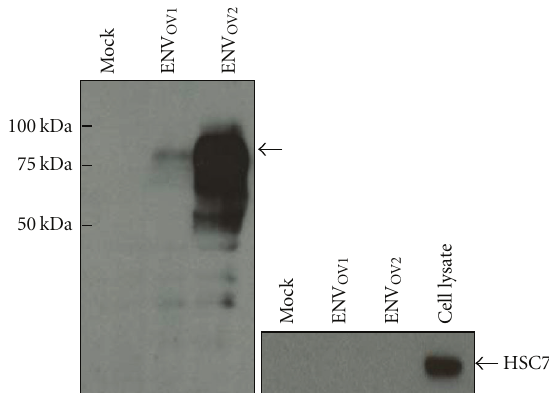
Figure 3: Production of pseudotype LacZ-MuLV virions. Pres- ence of the pseudotype LacZ-MuLV virus particles in culture supernatants of the GP2-293 packaging cells was confirmed by detection of the env polypeptides using antibody against Rauscher MuLV gp69/71. Arrow indicates the env polypeptides. Supernatants collected from cells transfected with a blank plasmid serves as a negative control